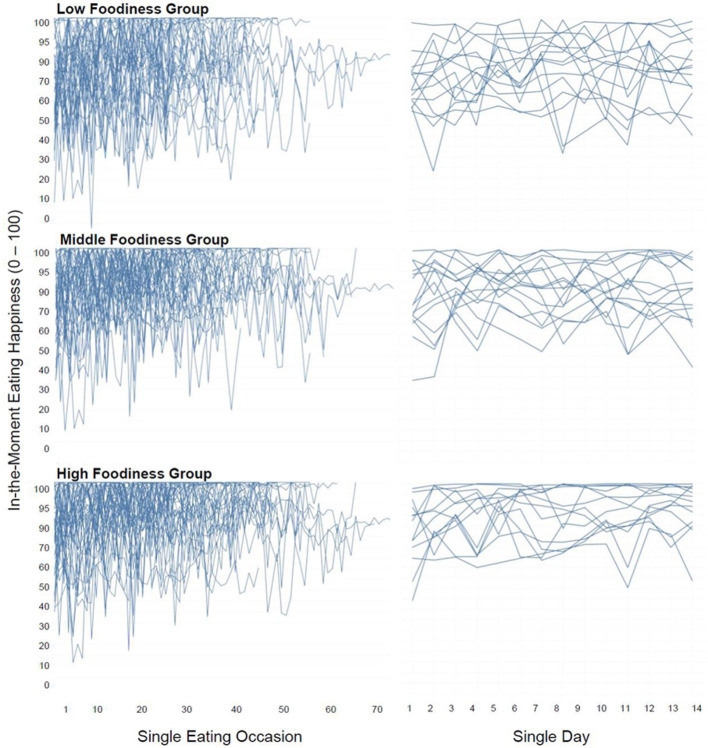
Variation of eating happiness experienced in-the-moment between eating occasions and between assessment days, separated by foodiness groups. Each participant is indicated by a separate line.